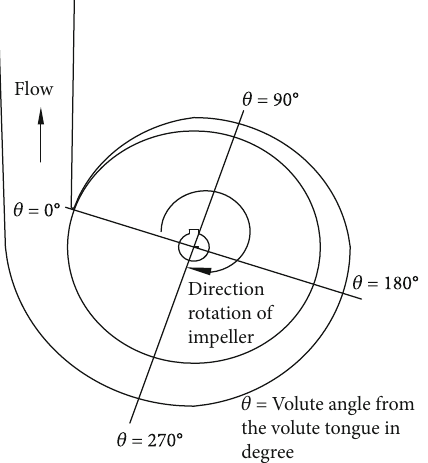
Figure 5: Schematic view of the volute casing with the location of volute